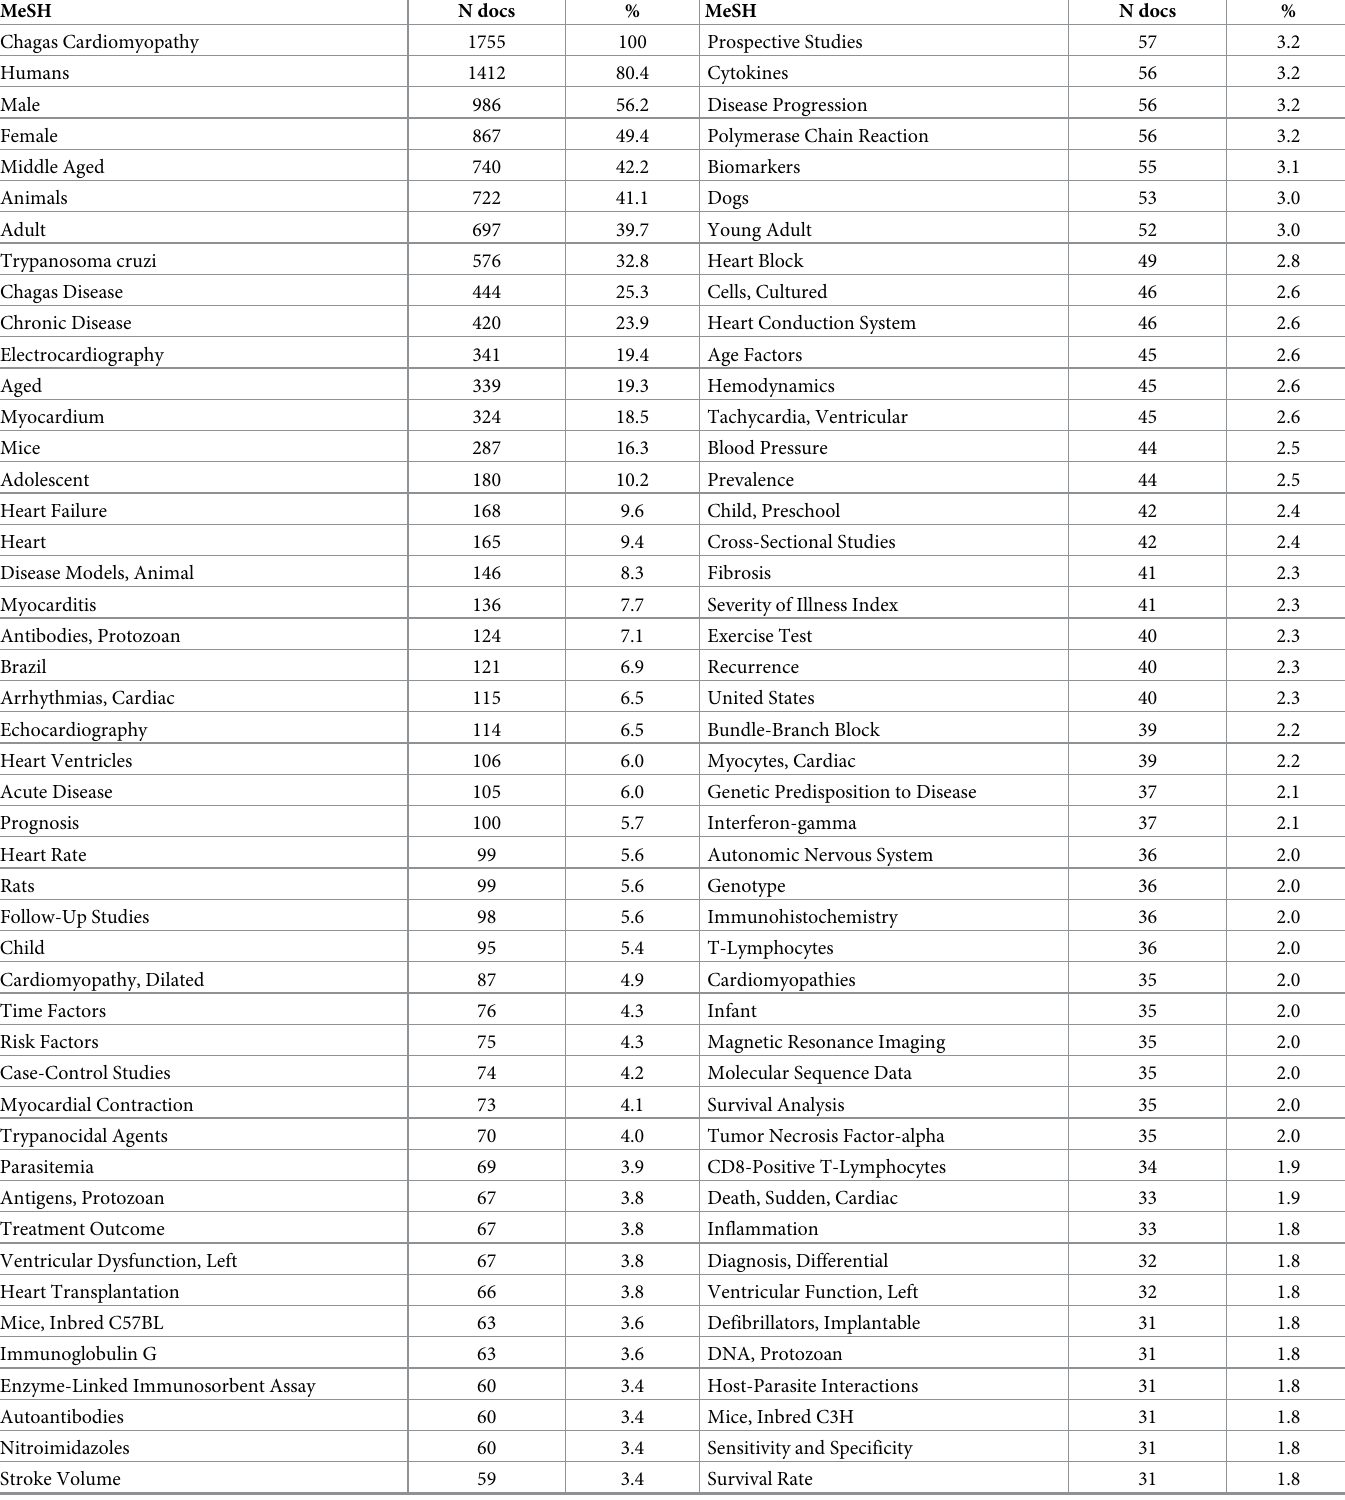
Table 8. Top 100 Medical Subject Headings (MeSH) from Chagas cardiomyopathy, records indexed in MEDLINE. MeSH N